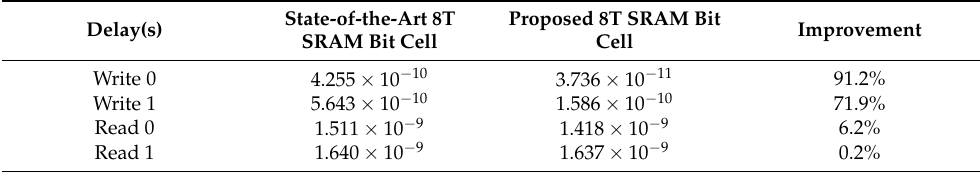
Table 5. Delay comparison of proposed 8T SRAM bit cell with state-of-the-art 8T SRAM bit cell